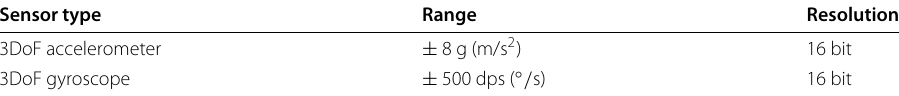
Table 1 Sensor specification for data